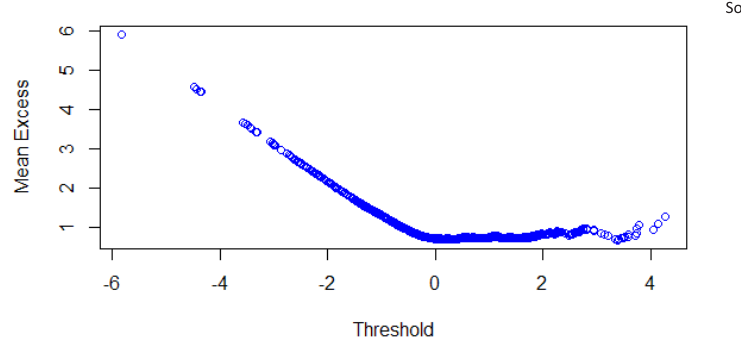
Figure 3. Mean excess function for BTC/USD returns